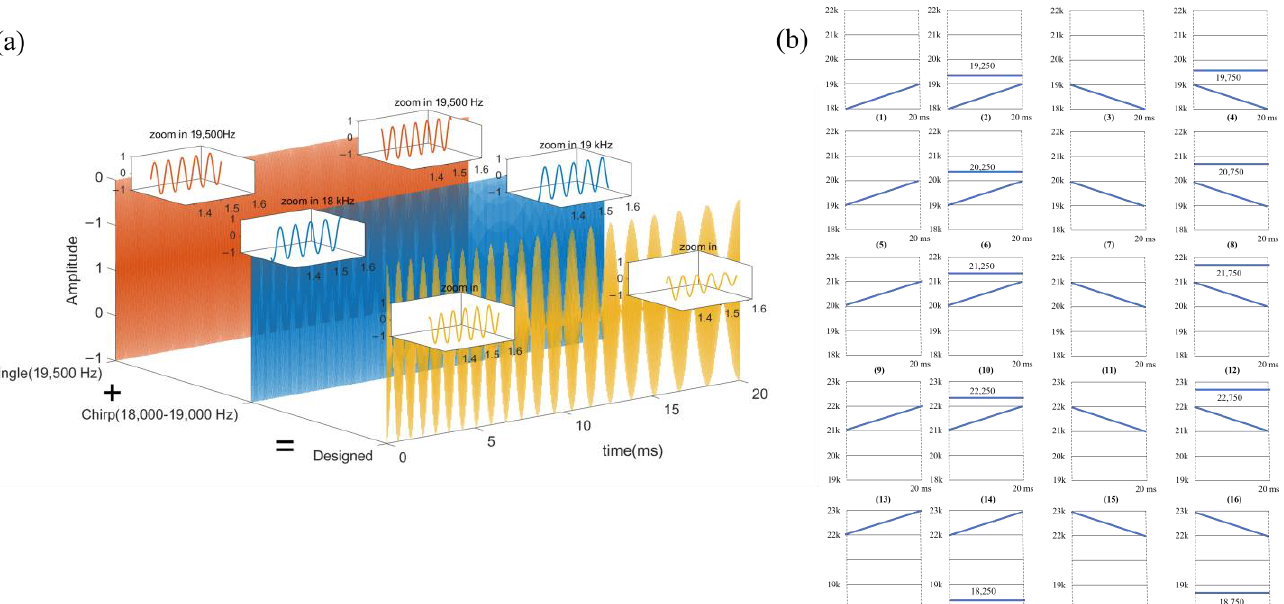
Figure 10. Signal design with coding and ranging functions. ( a ) Schematic diagram of the signal design. ( b ) The time-frequency diagram of the 20 designed near-ultrasonic signals.